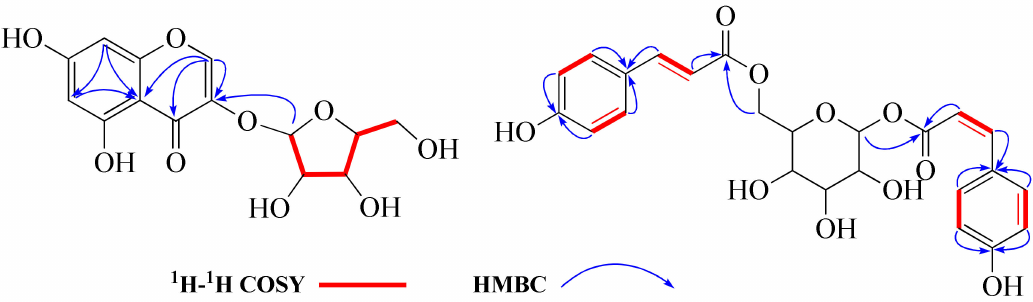
Figure 6. 1 H- 1 H COSY and key HMBC correlations of compounds 12 and 29 . Compound 29 , a yellow amorphous powder (Figure 7), had a molecular formula of C 24 H 24 O 10 based on HRESIMS at m/z 471.1286 [M-H] - (calcd for 471.1290) and correspond- ing to 13 degrees of unsaturation. A comparison of the 1 H- and 13 C-NMR spectroscopic data of 29 (Table 3) with those of 1,6-di- O -( E )-coumaroyl- β - D -glucopyranoside ( 30 ) sug- gested that these two compounds were closely related in structure [17], while the